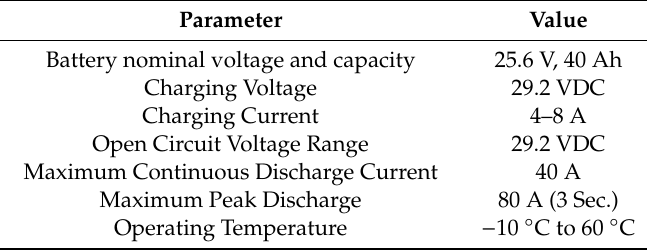
Table 2. Summary of battery specifications